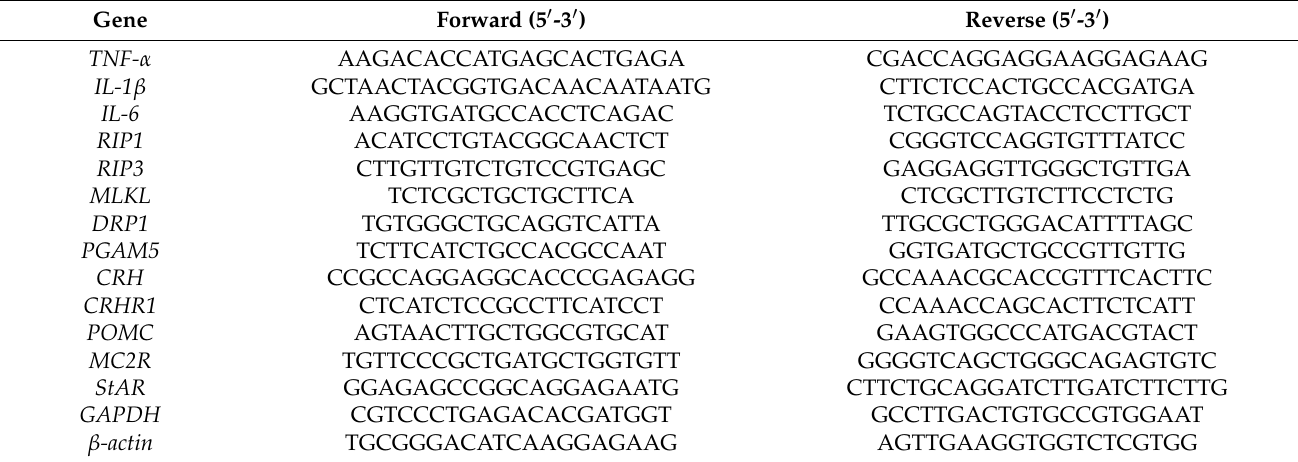
Table 1. Primer sequences used in real-time